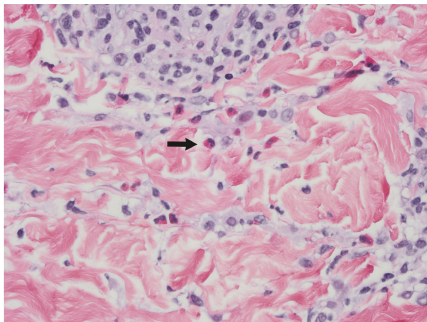
Figure 1: Skin biopsy demonstrating a perivascular and interstitial lymphohistiocytic infiltrate with numerous eosinophils (arrow). Hematoxylin-eosin stain,